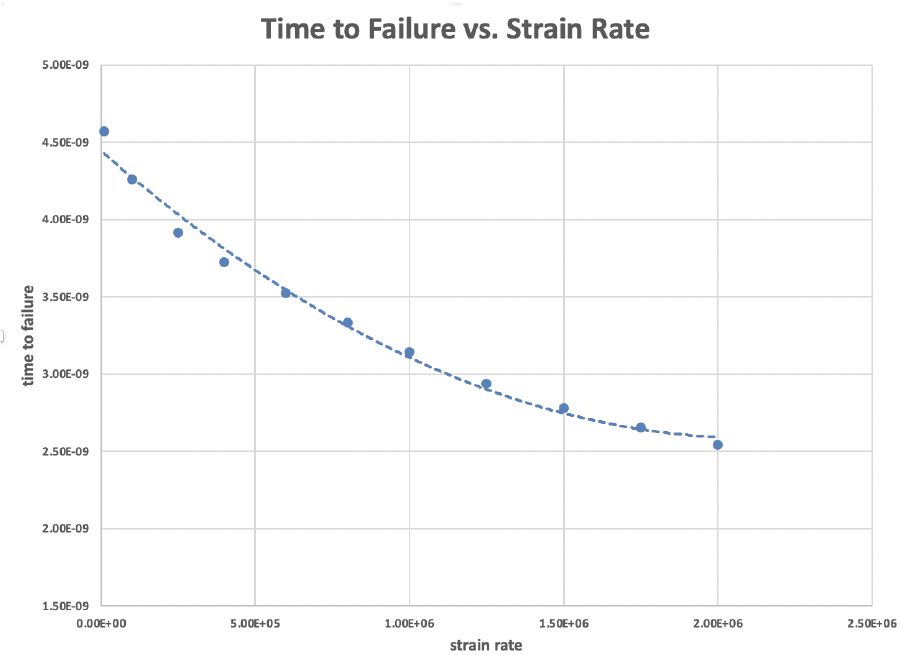
Figure 3. The ensemble-averaged time to failure is plotted as a function of strain rate. The ensemble size is 100 and the process zone is 10% of the crack radius. The time to failure decreases monotonically with strain rate and the curve is captured by a quadratic trendline with R 2 = 0.989.